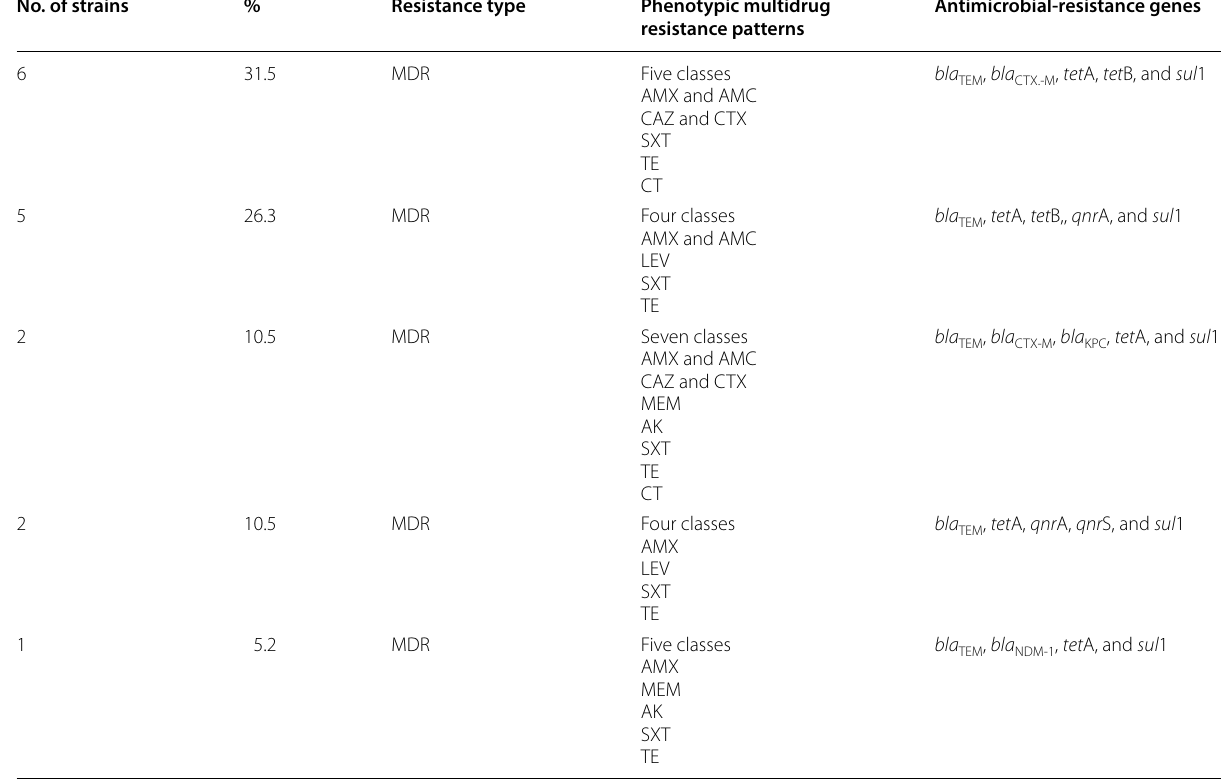
Table 3 The distribution of multidrug‑resistance patterns and the corresponding‑resistance genes among the tested E. coli isolates ( n 19) = No. of strains % Resistance type Phenotypic multidrug